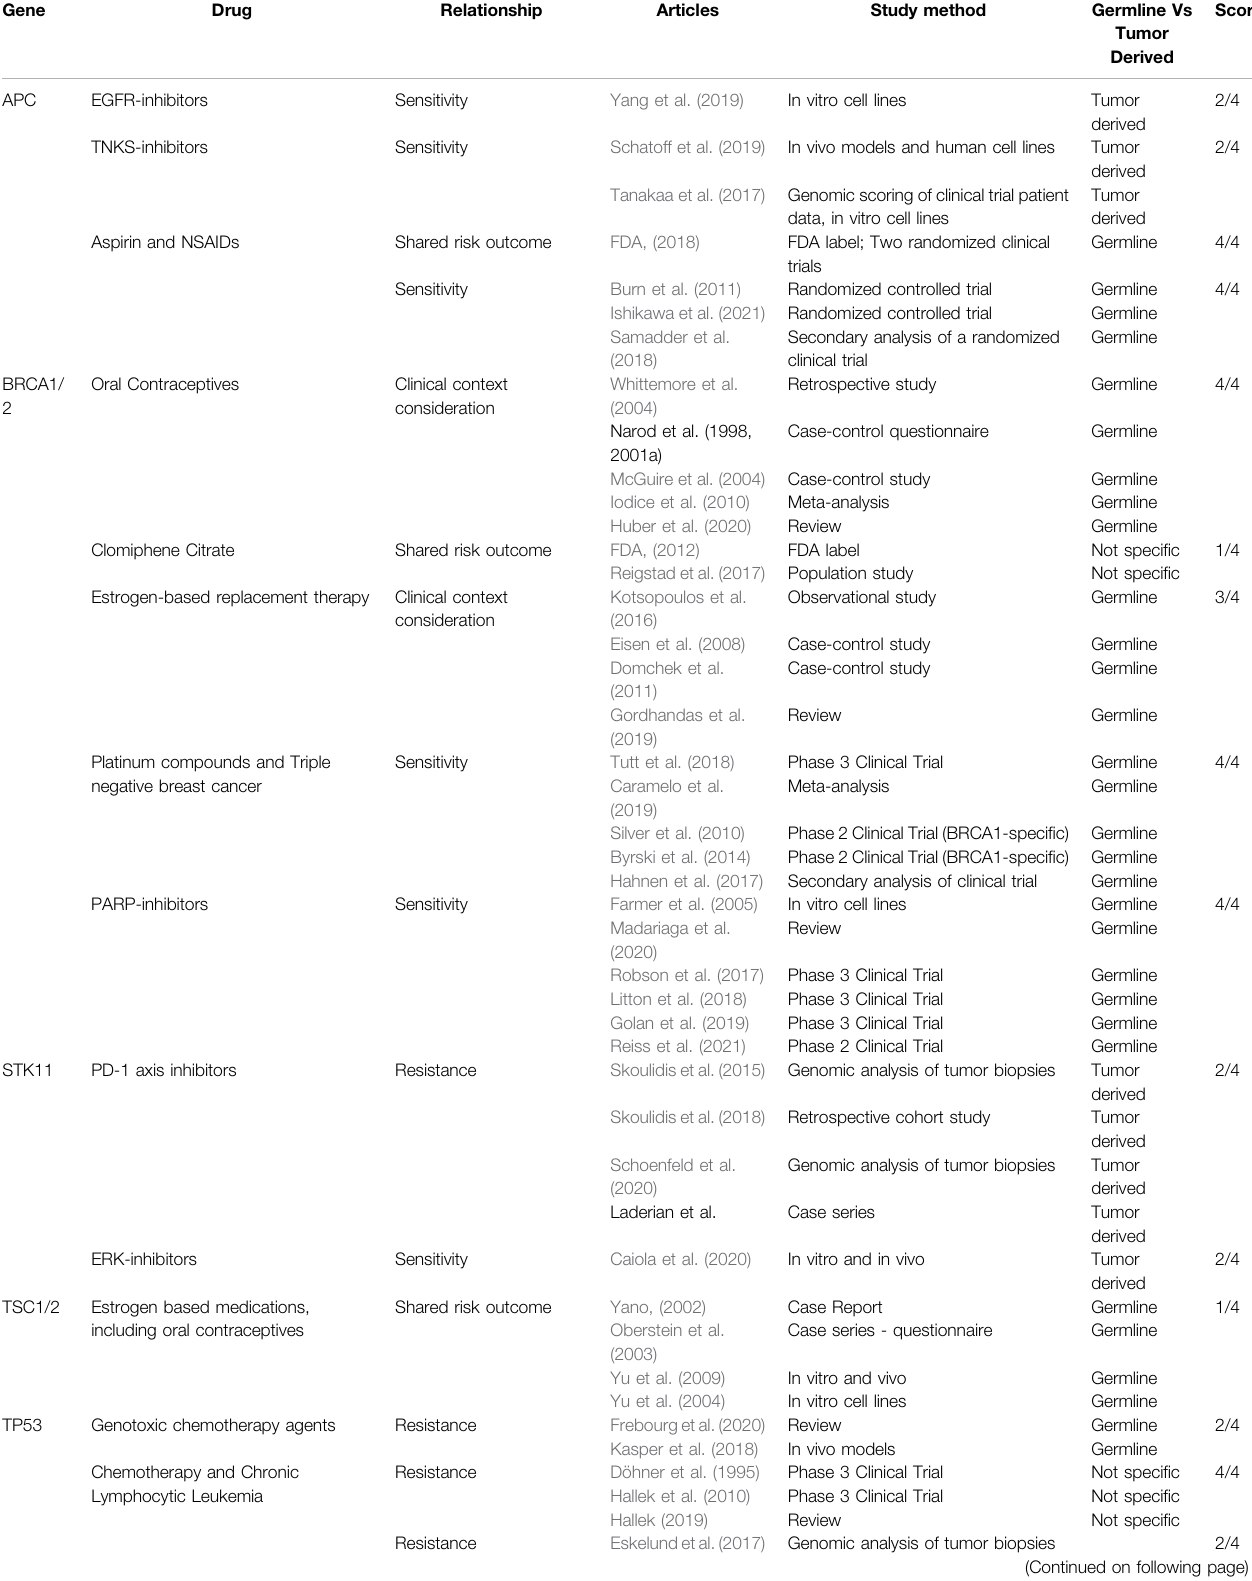
TABLE 1 | Gene-drug